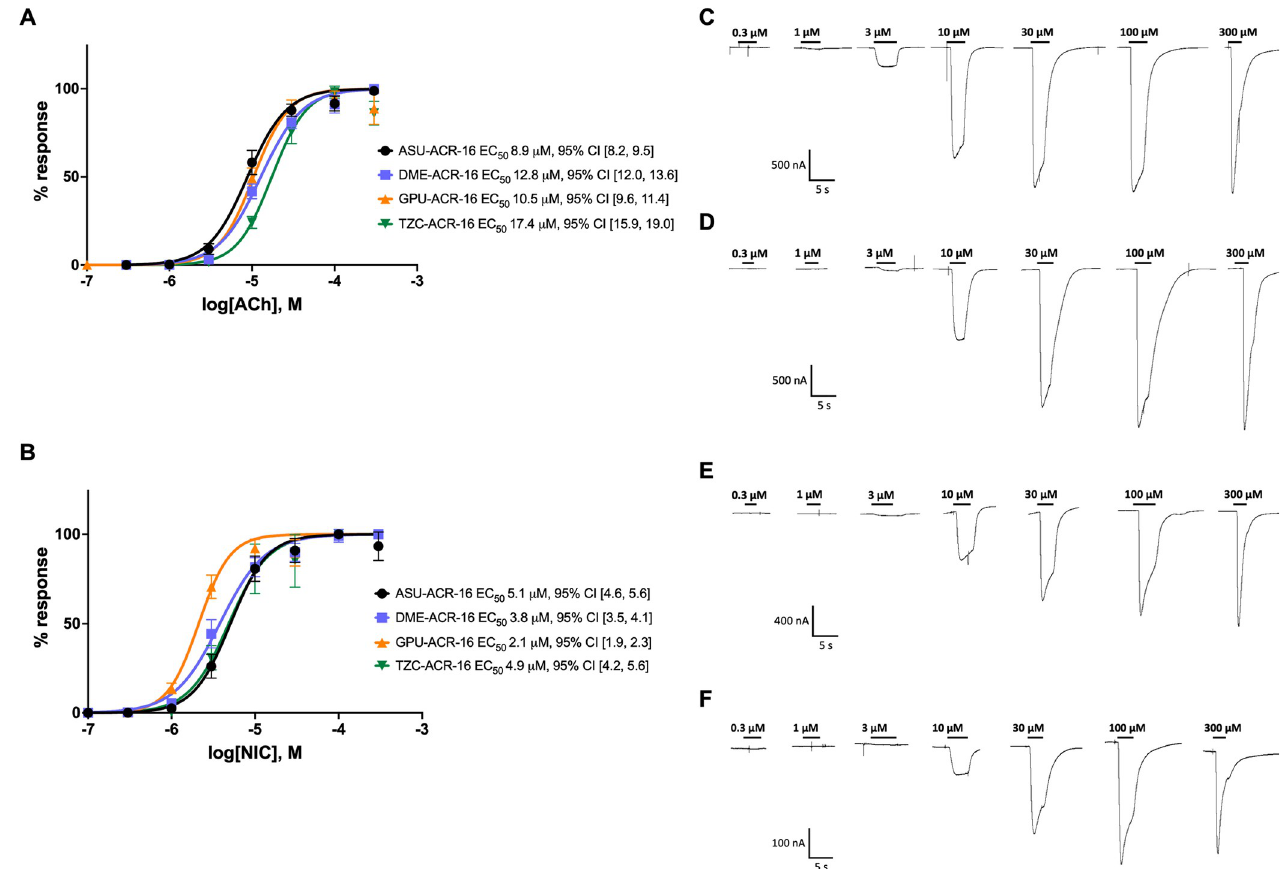
Fig 4. Clade III N-AChR show similar agonist affinities. Concentration- response curves were measured to determine if declining maximal response is due to decreasing ligand affinity. Concentration-response curves for clade III N-AChRs for (A) acetylcholine and (B) nicotine. In order of phylogeny; A . suum in black, D . medinensis in blue, G . pulchrum in orange, T . callipaeda in green. EC 50 were A . suum 8.9 μ M, 95% CI [8.2, 9.5] (hill coefficient = 1.8, 95% CI [1.6, 2.1]; n = 11) and 5.1 μ M, 95% CI [4.6, 5.6] (hill coefficient = 2.0, 95% CI [1.7, 2.3]; n = 13), D . medinensis 12.8 μ M, 95% CI [12.0, 13.6] (hill coefficient = 1.7, 95% CI [1.6, 1.9]; n = 11) and 3.8 μ M, 95% CI [3.5, 4.1] (hill coefficient = 1.6, 95% CI [1.4, 1.8]; n = 14), G . pulchrum 10.5 μ M, 95% CI [9.6, 11.4] (hill coefficient = 2.1, 95% CI [1.7, 2.5]; n = 15) and 2.1 μ M, 95% CI [1.9, 2.3] (hill coefficient = 2.3, 95% CI [1.9, 2.7]; n = 13), T . callipaeda 17.4 μ M, 95% CI [15.9, 19.0] (hill coefficient = 2.1, 95% CI [1.7, 2.4]; n = 10) and 4.9 μ M, 95% CI [4.2, 5.6] (hill coefficient = 1.9, 95% CI [1.5, 2.3]; n = 14), for acetylcholine and nicotine, respectively. Representative recordings in response to acetylcholine are shown for (C) A . suum . (D) D . medinensis , (E) G . pulchrum and (F) T . callipaeda . Similar concentration-response curves confirm the declining response is not due to changes in agonist affinity. Error bars represent standard deviation.